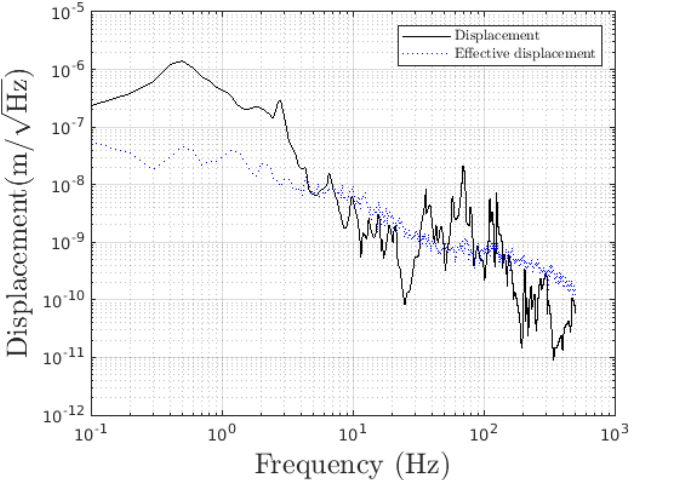
Figure 14. Comparison of effective (in dotted blue) and original (in black)